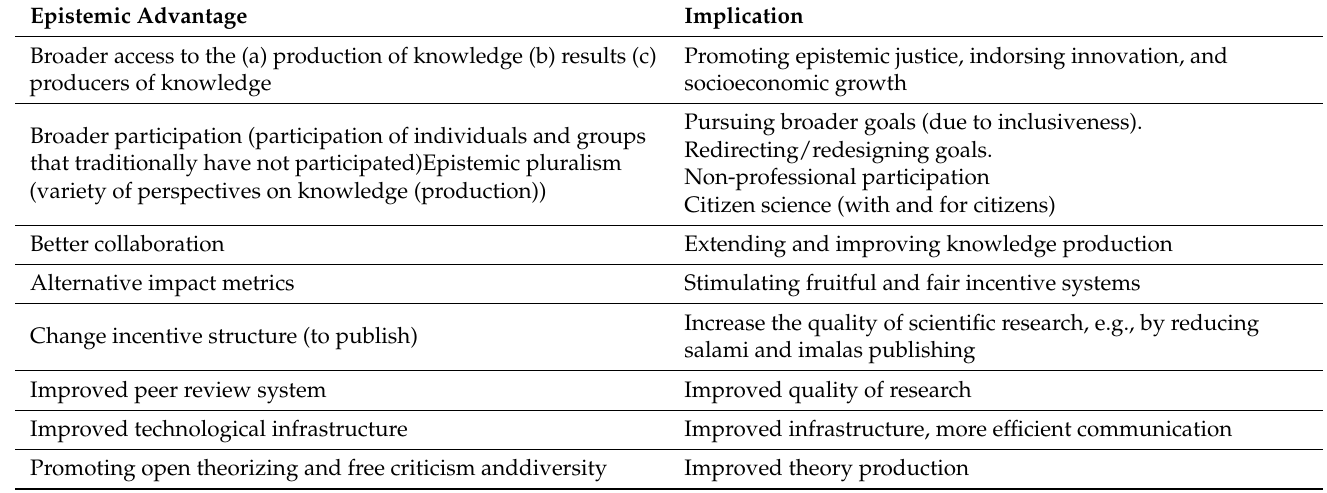
Table 1. The most frequently mentioned epistemological advantages with OS compared to ordinary restricted access science. The table is not exhaustive but only provides a summarizing overview of the